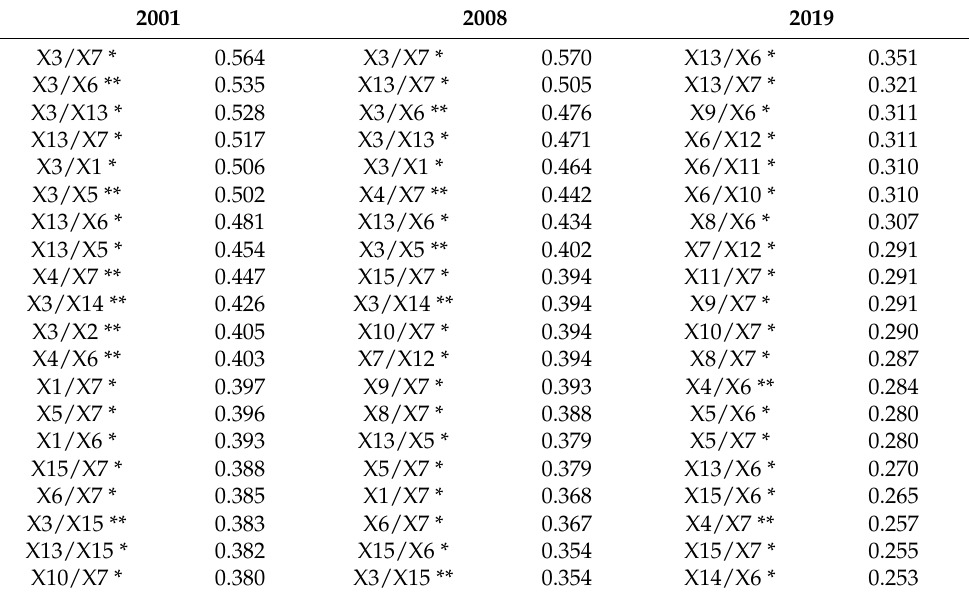
Table 6. Interaction results for selected factors of ecological vulnerability in the